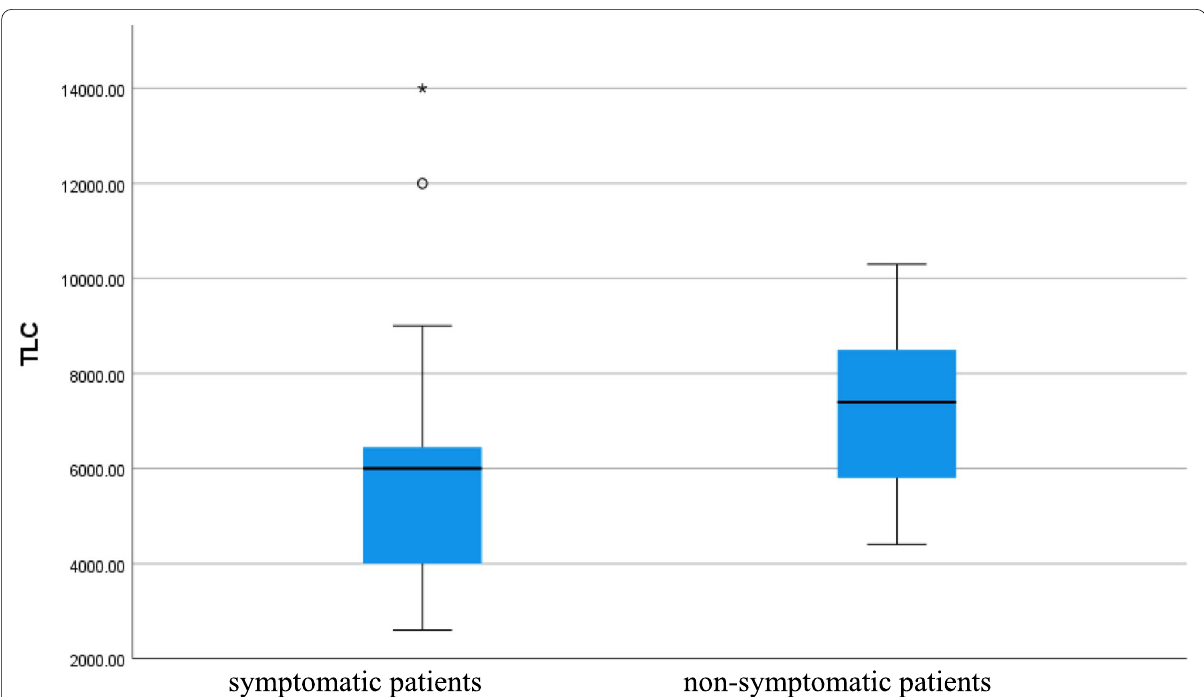
Fig. 3 Total leucocytic count of COVID 19 patients (symptomatic and non-symptomatic)